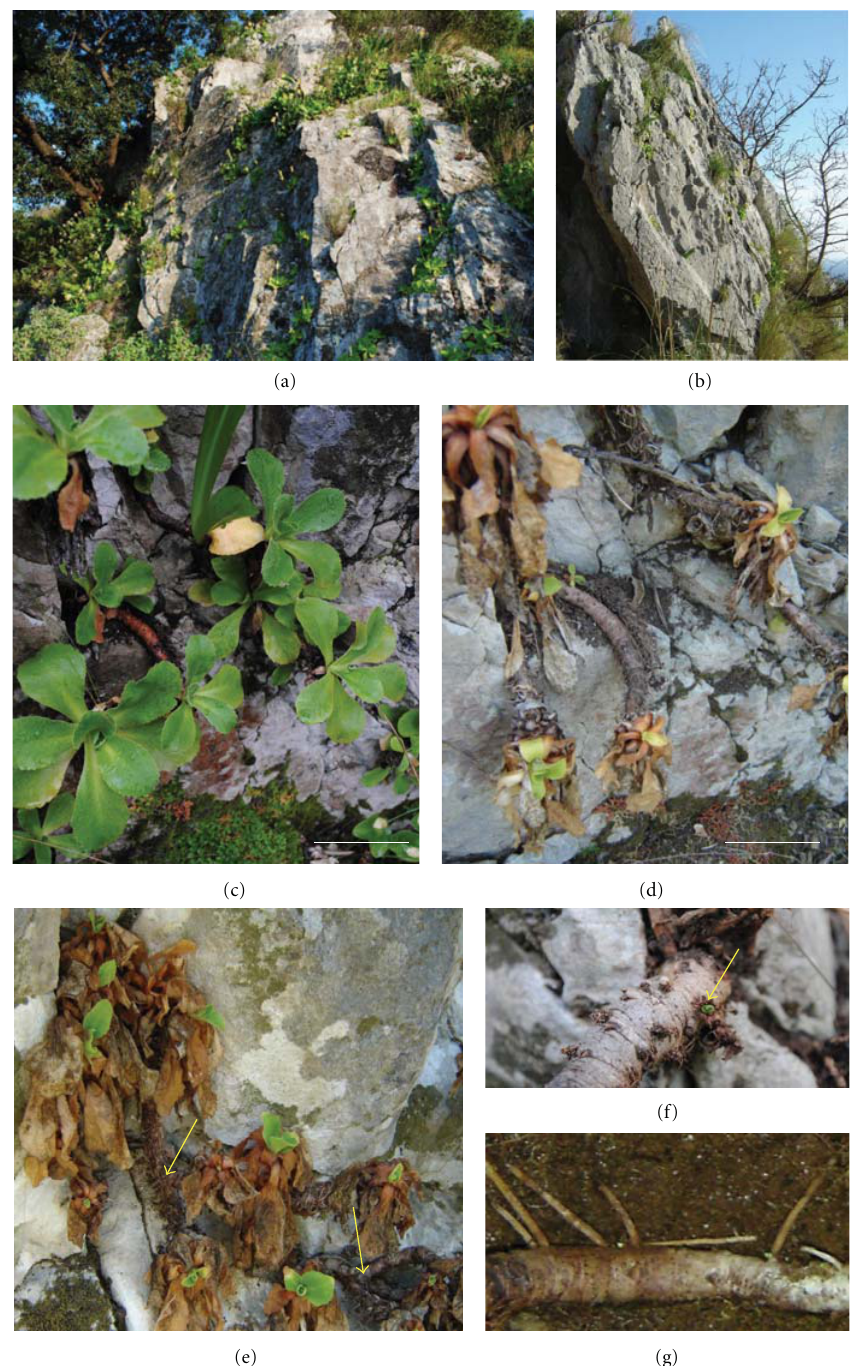
Figure 3: Adult plants of P. palinuri : (a)-(b) view of plants growing on the cli ff s; (c) plants in the winter habitus ; (d) plants in the summer habitus with wilting and shedding leaves; (e) branched rhizome of a single plant developing upside down; (f) rhizome with bursting lateral bud (arrow); (g) adventitious roots emerging from the rhizome and acting as tie-rods. Bars are 5cm in (c)-(d).